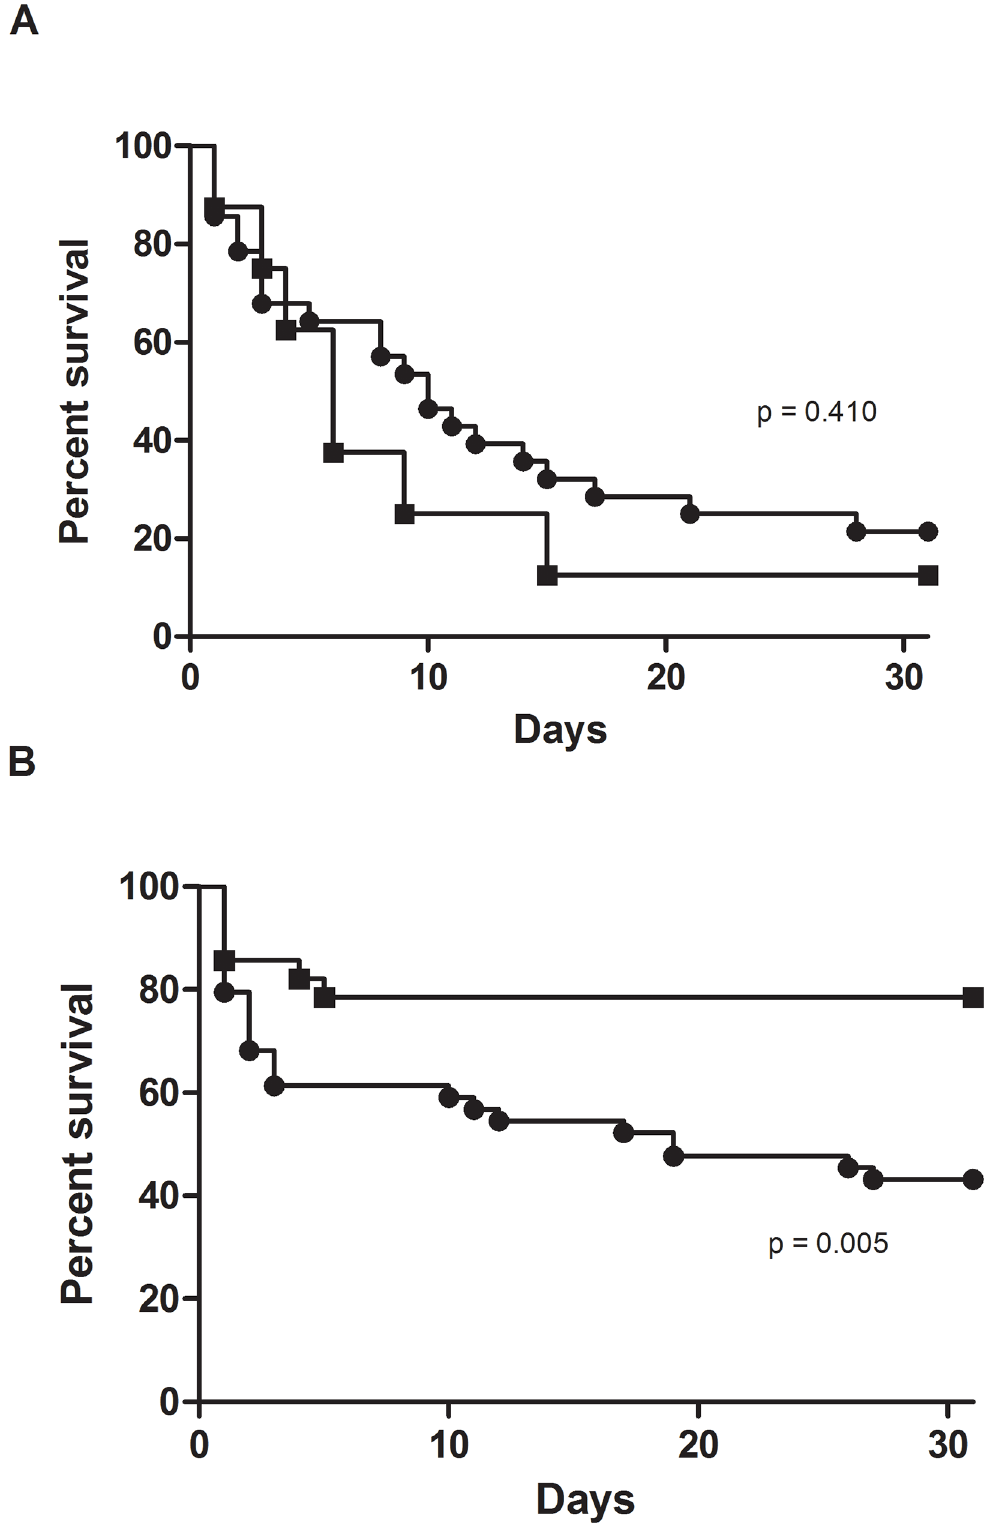
Fig 1. 30-days survival of older (circle) vs younger(squares) patients with candidemia with septic shock (A) and without any antifungal therapy (B).